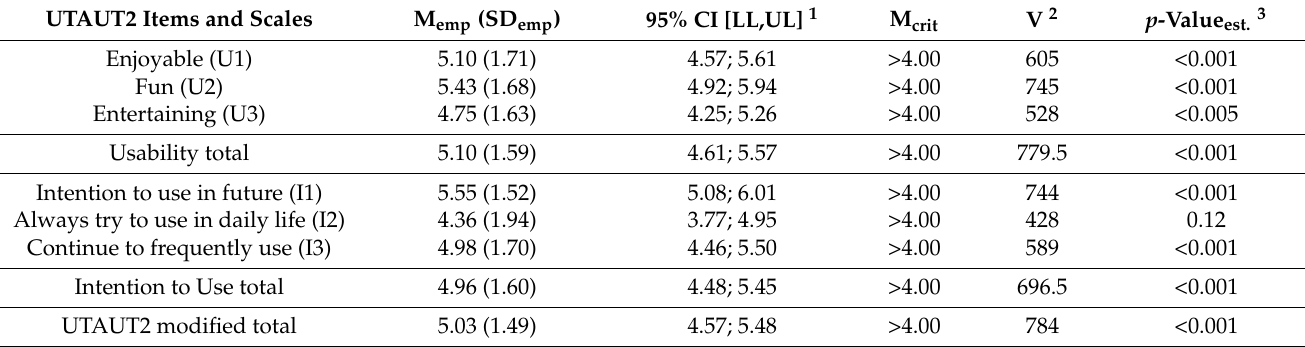
Table 7. Modified UTAUT2 ratings of vStop HMI prototype by participants of the second user study (N =